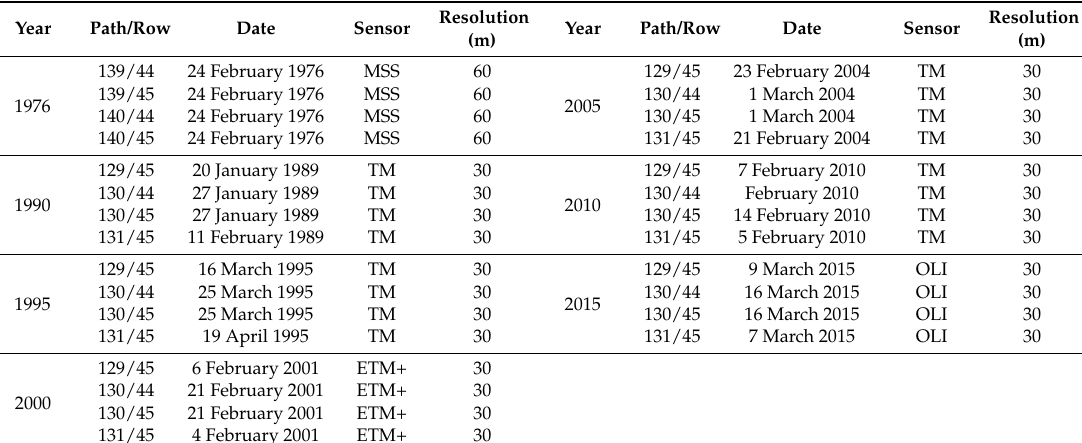
Table 1. List of Landsat remote sensing